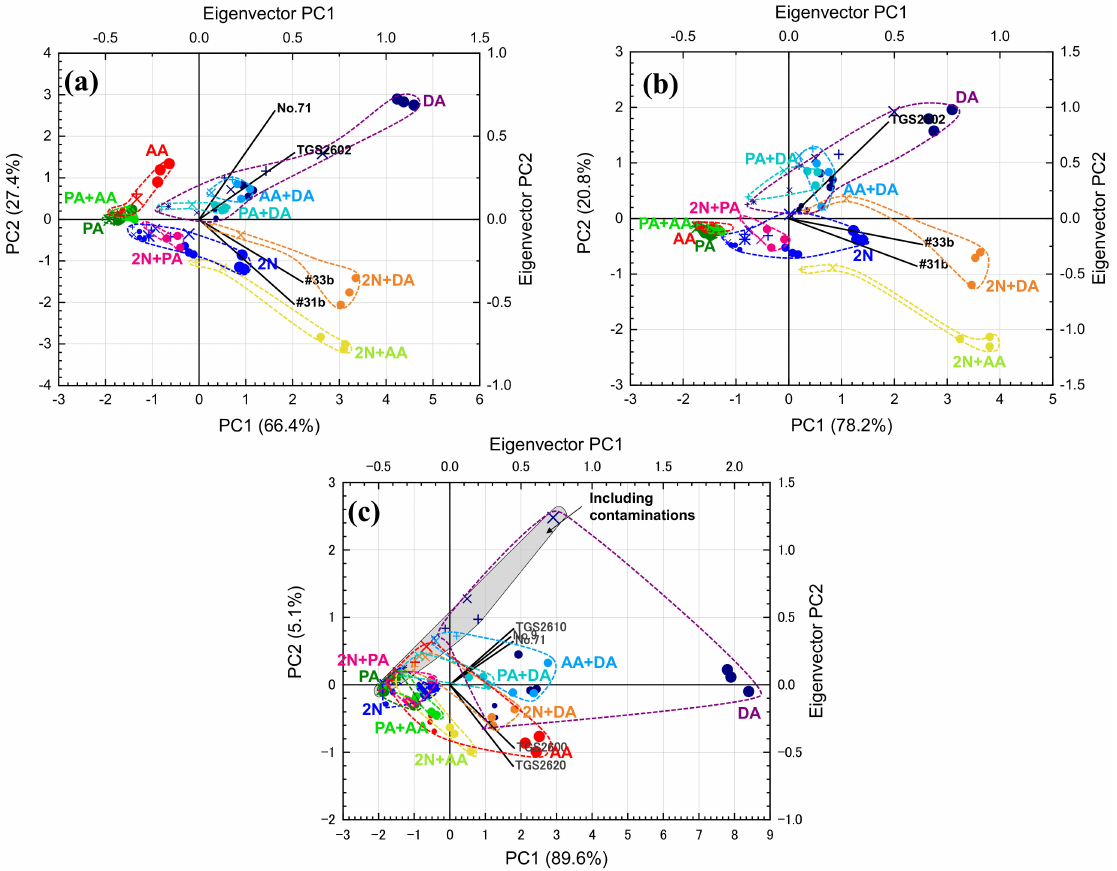
Figure 9. PCA scores and eigenvectors from ( a ) four sensors selected by random forest, ( b ) three sensors selected by ReliefF, and ( c ) five sensors not selected by